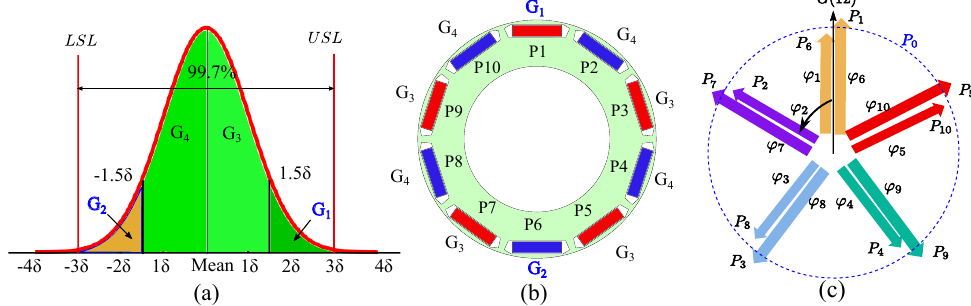
Figure 9. The PM categorized and assembling approach. ( a ) PM categorised approach based on the uncertainty range, ( b ) the assembling method to reduce the effects of uncertainties, ( c ) the corresponding vector diagram for analyzing the additional 12th cogging